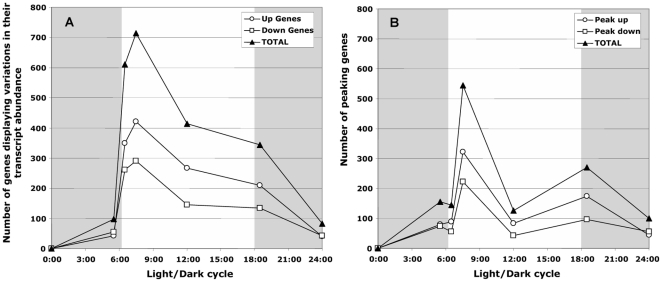
Temporal distribution of genes displaying significant changes in their transcript abundance vs. that at T0.
A. Number of genes displaying an increase (Up genes) or a decrease (Down genes) in their transcript abundance during the light/dark cycle. B. Number of genes displaying a zenith of their transcript abundance (Peak up) or the nadir of their transcript abundance (Peak down) during the light/dark cycle. The gray shaded part of the figure represents the dark period of the light/dark cycle.